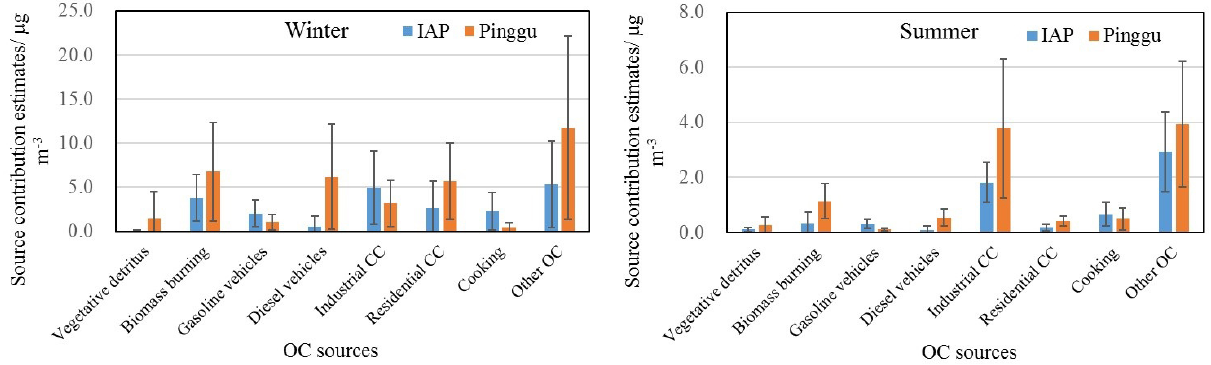
Figure 7. Comparison of the source contribution estimates (SCE in µgm − 3 ; %OC) at IAP with those at a rural site in